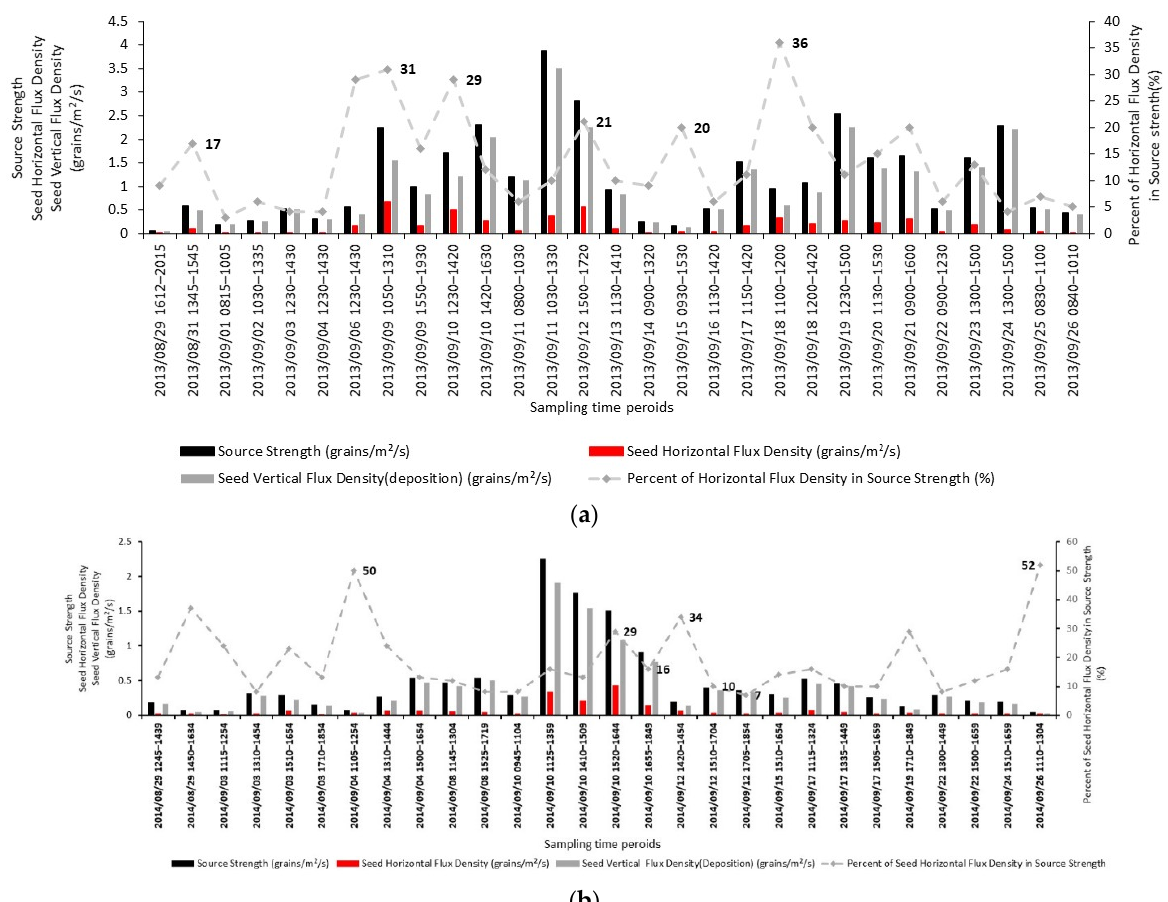
Figure 4. Composition of source strength at the ( a ) Illinois source field; ( b ) Tennessee source field. Source strength (grains/m 2 /s) for every sampling period was composed of the integrated horizontal and vertical flux density. The black bars were the source strength, grey bars were the vertical flux density (first term in Equation (9)), and the red bars were the seed horizontal flux density (second term in Equation (9)). Dotted lines were the percentage of horizontal flux density in seed source strength.